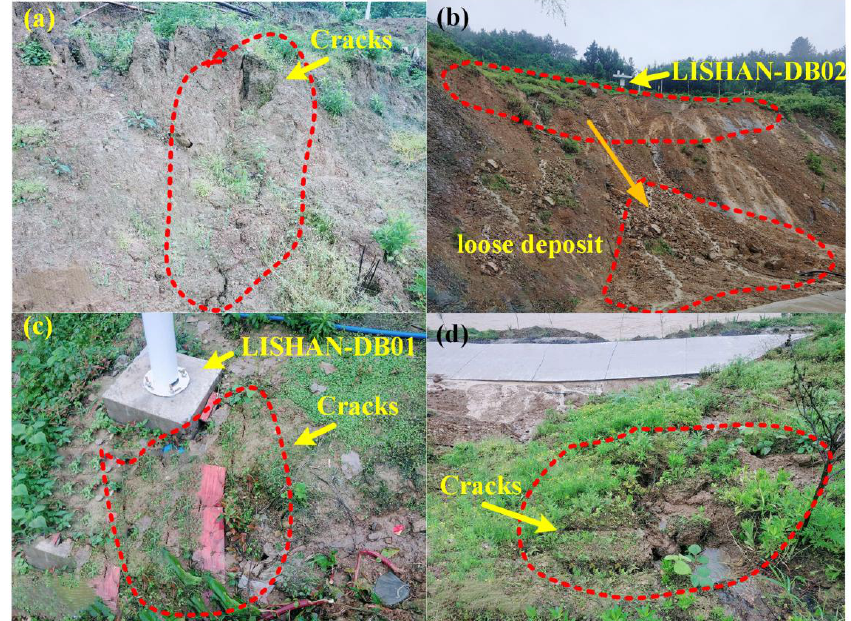
angle calculated by the proposed method are smooth, and can reflect each acceleration Figure 8. Photos of the Lishanyuan landslide on 19 May. Figure 8. Photos of the Lishanyuan landslide on 19 May.